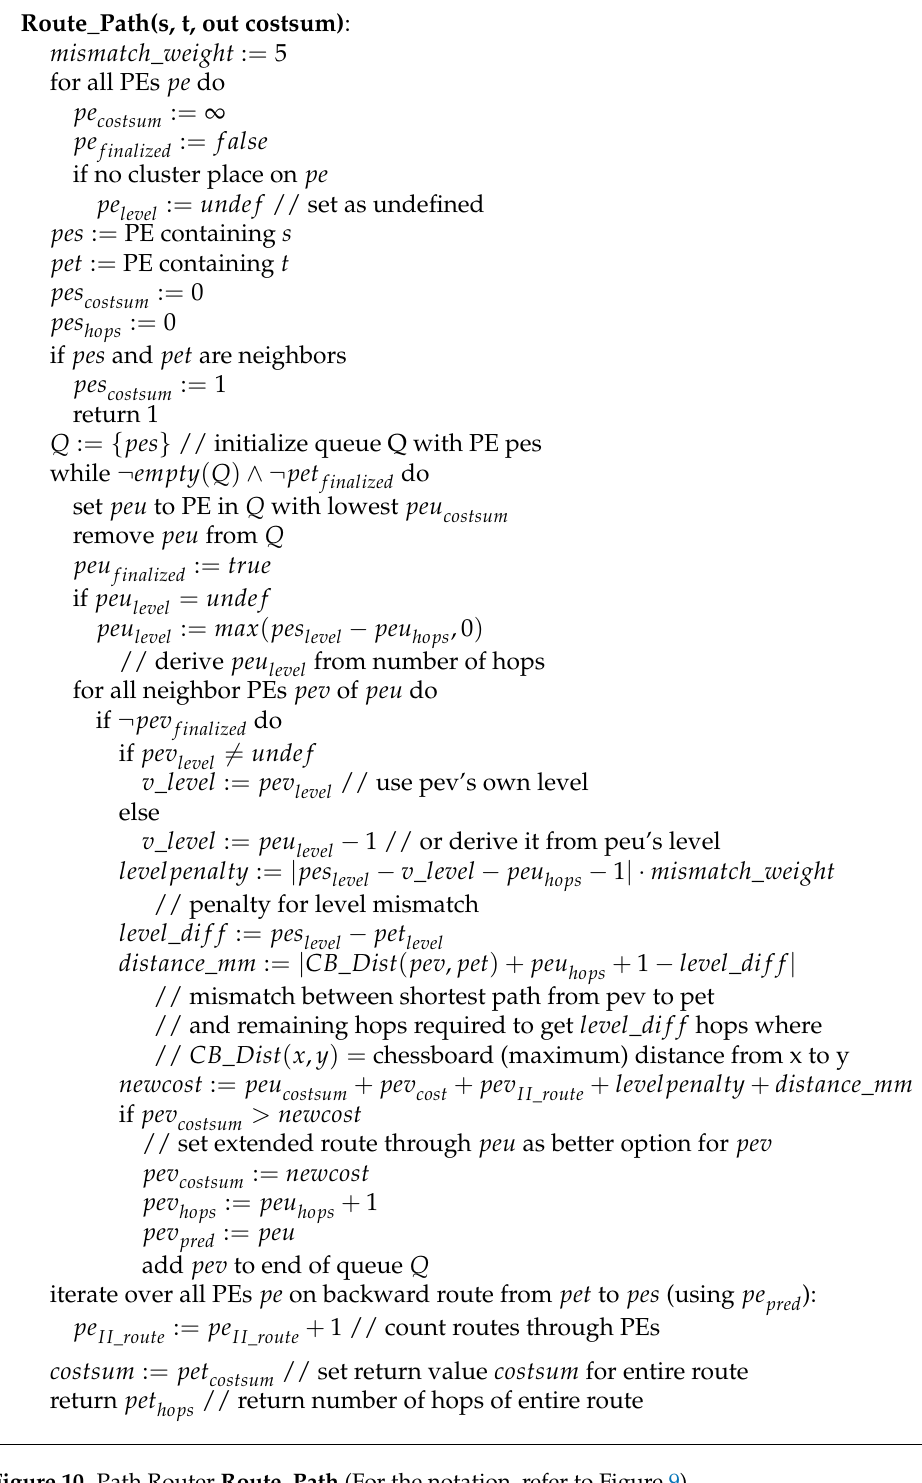
Figure 10. Path Router Route_Path (For the notation, refer to Figure 9). Next, all neighbors pev of peu are examined, i.e., the search frontier is expanded. The goal is to find an optimal path pes ... ... peu pev pet , i.e., a complete route. → → → → → If pev is not yet finalized and pev (which is initialized to infinite) is higher than costsum newcost (the cost of the path to pev via peu ), a route from pes over peu to pev is added (by setting pev , pev and pev ). Of course, if a cheaper path to pev is found later, costsum hops pred this information is